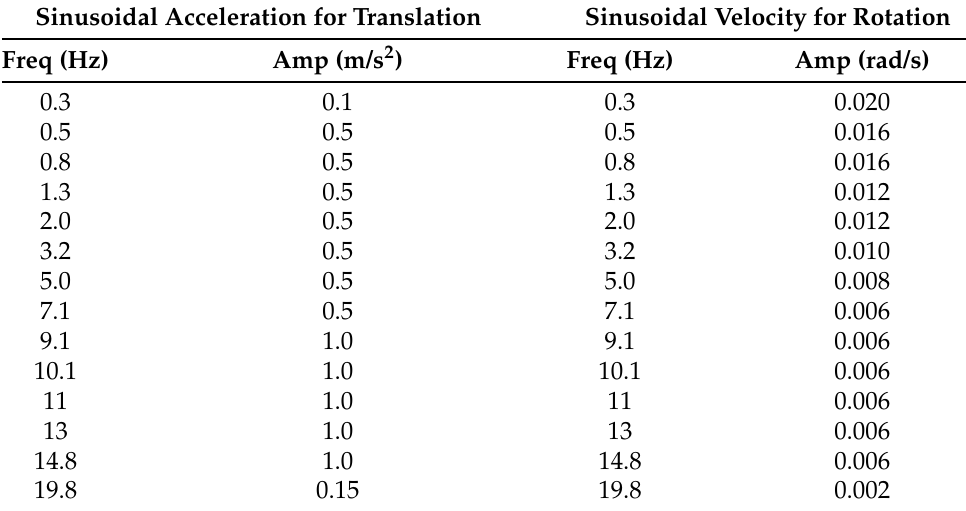
Table 3. Operating points for describing function tests.